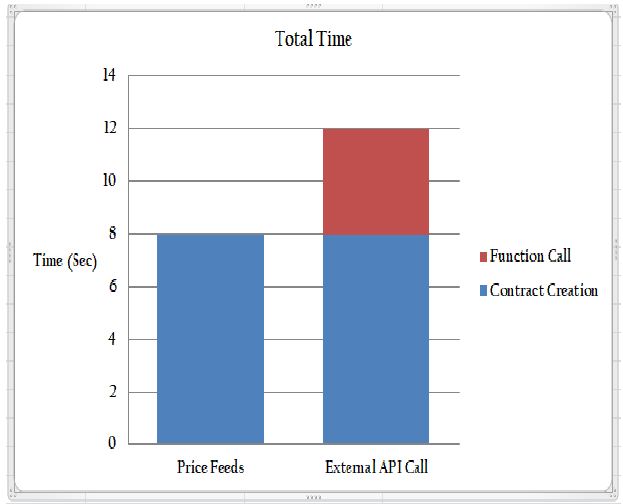
Fig. 7. Comparison of total response